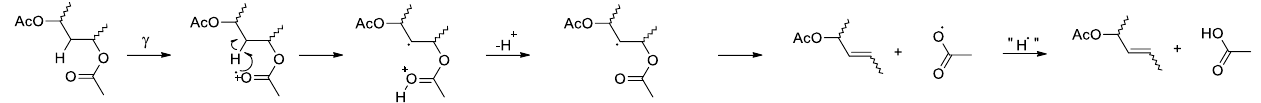
Scheme 5. Radical pathway for the formation of acetic acid. Reproduced from [28] with the permission of Polymer Degradation and